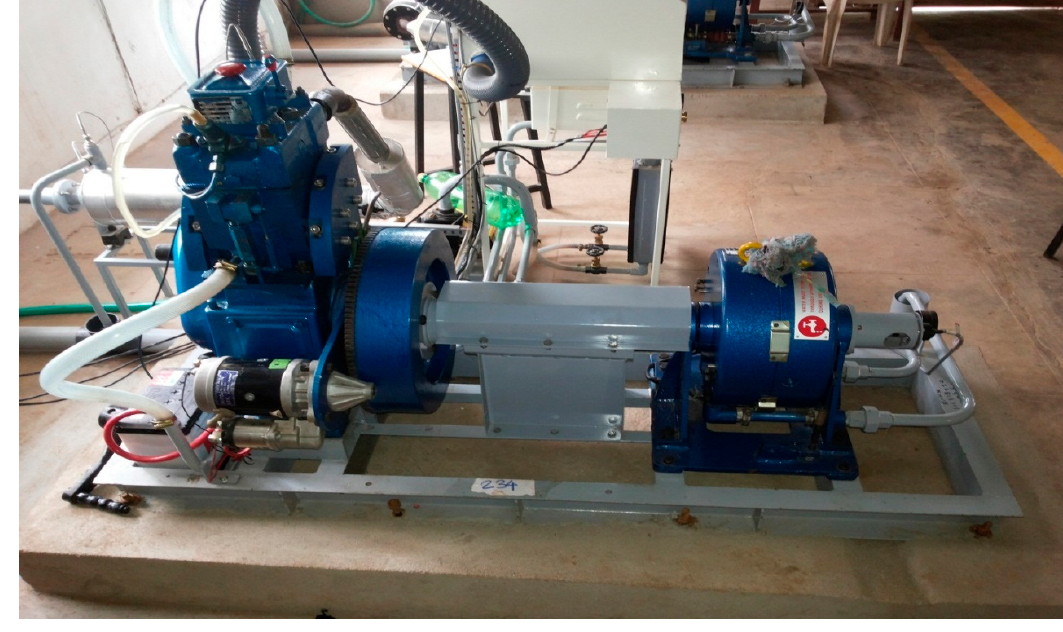
Figure 1. Variable compression ratio diesel engine. Table 2. Technical specifications of the